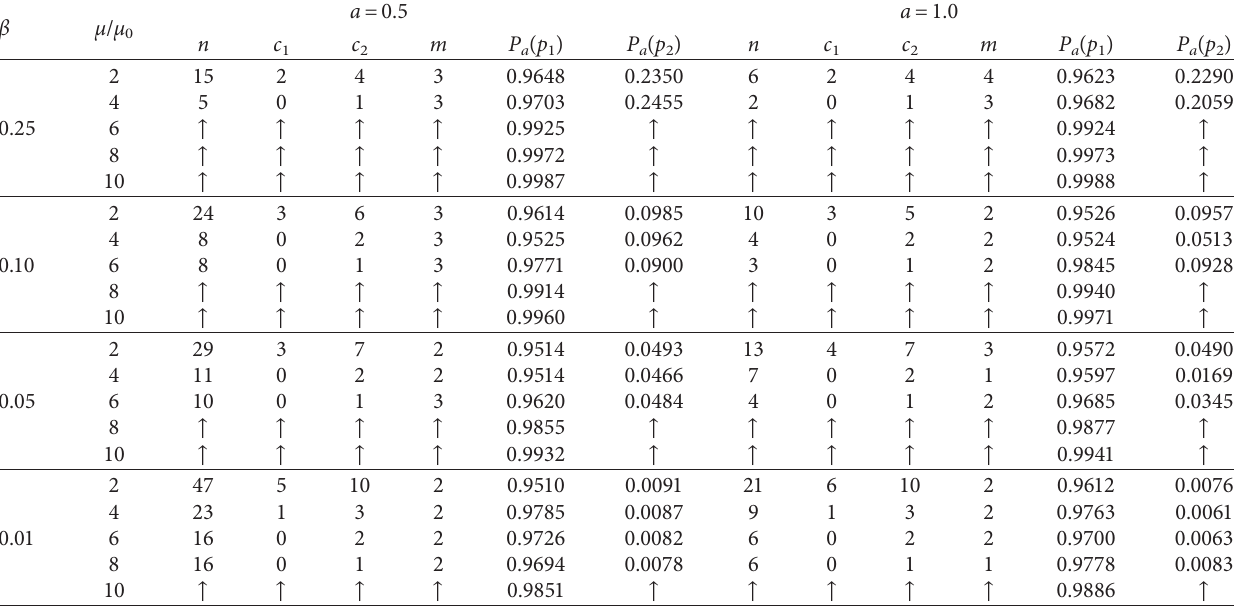
Table 5: Plan parameters of modified MDS sampling plan for Weibull distribution with δ � 1.5.